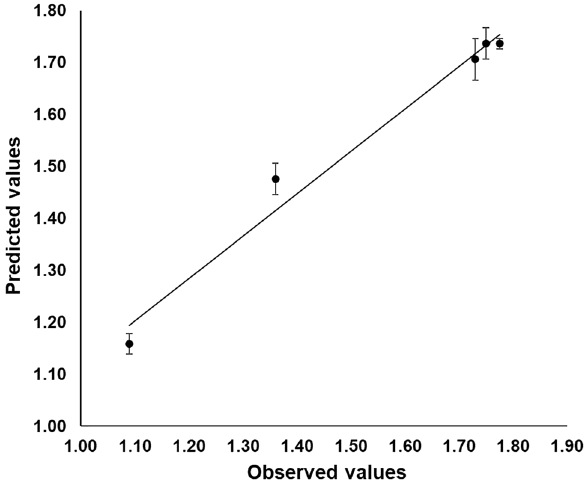
Figure 4. Fitted line plot between the observed and predicted values of dry cell mass in the validation